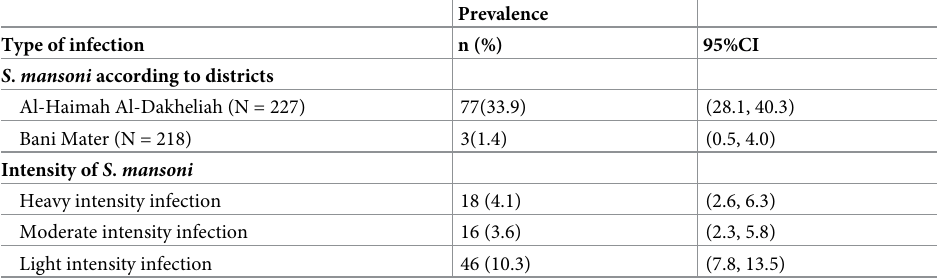
Table 2. Distribution of Schistosoma mansoni infection among schoolchildren in the rural areas of Sana’a Gover- norate, Yemen (N = 445).